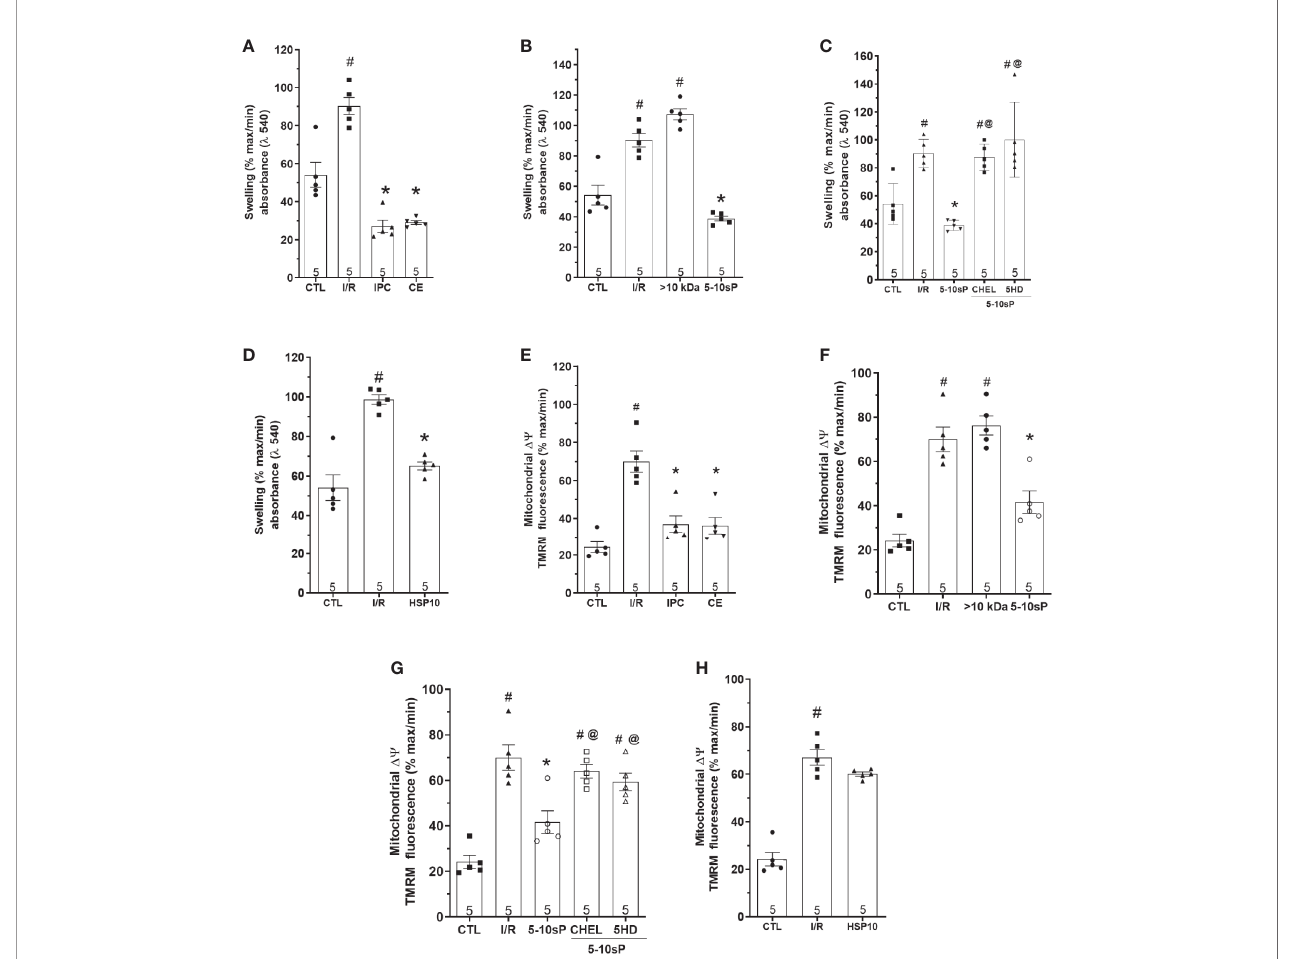
FIGURE 7 | Mitochondrial swelling and mitochondrial transmembrane potential ( Dy m) of isolated mitochondria from rat hearts. (A – D) Mitochondrial swelling and (E – H) mitochondrial Dy m in isolated mitochondria from hearts submitted to I/R. Control (CTL), ischemia/reperfusion (I/R), ischemic preconditioning (IPC), preconditioned coronary ef fl uent (CE) transfer, coronary ef fl uent fraction 5 – 10 kDa (5 – 10-sP) transfer, coronary ef fl uent fraction >10 kDa (> 10 kDa) transfer, 5 – 10-sP plus PKC inhibitor chelerythrine or mitochondrial K ATP channel blocker 5HD. (D) Mitochondrial swelling and (H) mitochondrial Dy m in isolated mitochondrial from hearts submitted to I/R, under 10 kDa-mitochondrial heat shock protein (HSP10) perfusion. Number in each column is n of hearts. # P < 0.05 vs . CTL, *P < 0.05 vs .